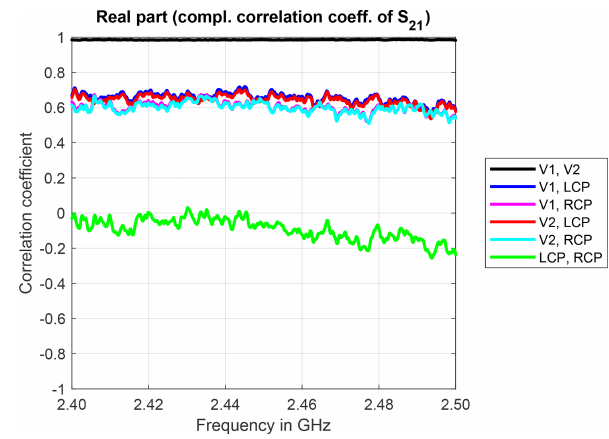
Figure 6. Average transmission for different antennas and measure- ment trial 4.